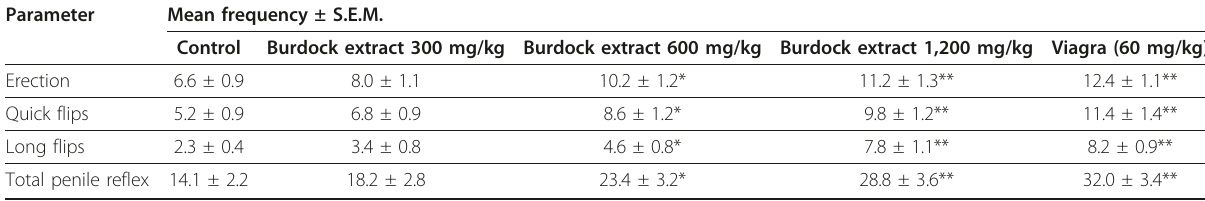
Table 3 Effect of aqueous extract of burdock roots on penile reflexes (test for potency) Parameter Mean frequency ±